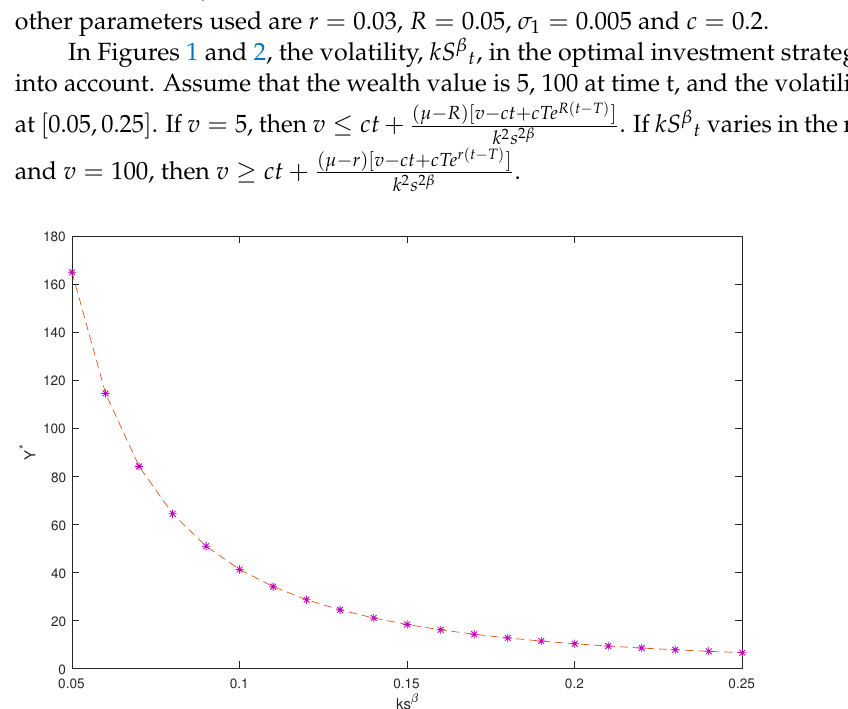
Figure 1. Influence of kS β t on Y ∗